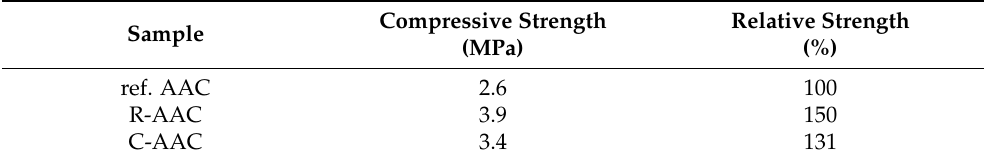
Table 4. Compressive strength of AAC samples.